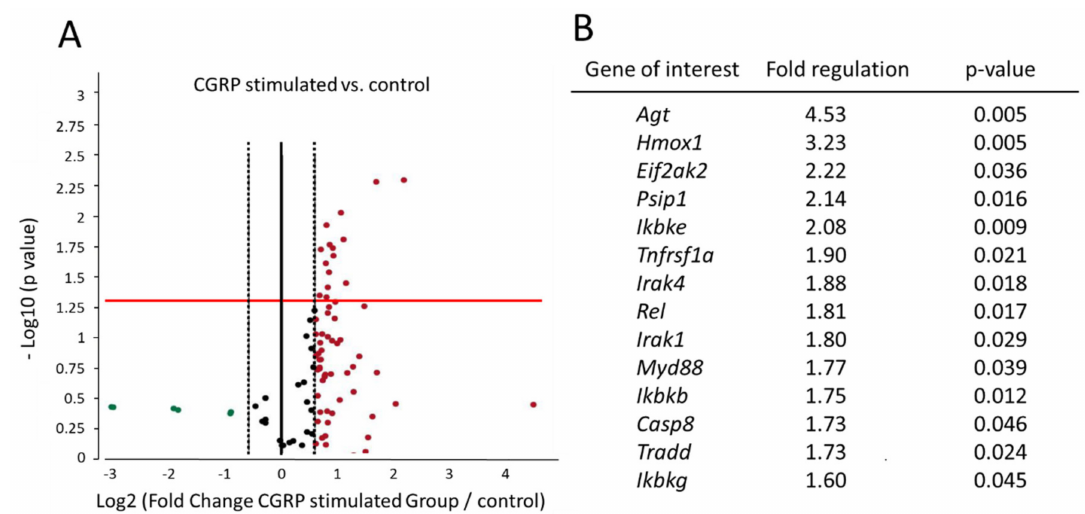
Figure 1. Fold regulation of various genes of NF- κ B signaling pathway in the glial cells of trigeminal ganglion (TG) after overnight stimulation with 1 µ M CGRP compared to no treatment control group. ( A ) Volcano plot showing RT-PCR array data to compare the normalized expression of all the genes included in the array between the CGRP stimulated group and control group (no treatment group). The red dots are the genes which were upregulated, and green dots were the genes which were down regulated. The red line shows where p = 0.05 with points above the line having p < 0.05 and points below the line having p > 0.05. Dots above the red line indicate genes-of-interest that display both more than 1.5-fold-changes ( x axis) and p < 0.05, statistical significance ( − log10 of p value, y axis). Those points having a fold-change less than 1.5 are shown in black dots. ( B ) Genes-of-interest, which were significantly upregulated after overnight stimulation with 1 micromolar CGRP compared to the no treatment control group. Fold Regulation cut o ff : 1.5; p -Value cut o ff : 0.05, n =